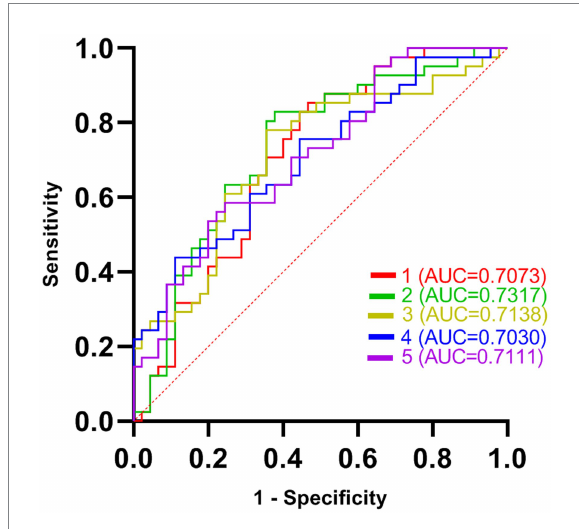
FIGURE 2 The receiver operating characteristic (ROC) curves of brain regions with abnormal degree centrality (DC) values in discriminating generalized anxiety disorder (GAD) patients from healthy controls (HCs). AUC represents the area enclosed by the coordinate axis under the ROC curve. Curve 1 represents the bilateral cerebellum; Curve 2 represents the left middle temporal gyrus; Curve 3 represents the left fusiform gyrus; Curve 4 represents the right medial orbital frontal gyrus; Curve 5 represents the bilateral posterior cingulate cortex.